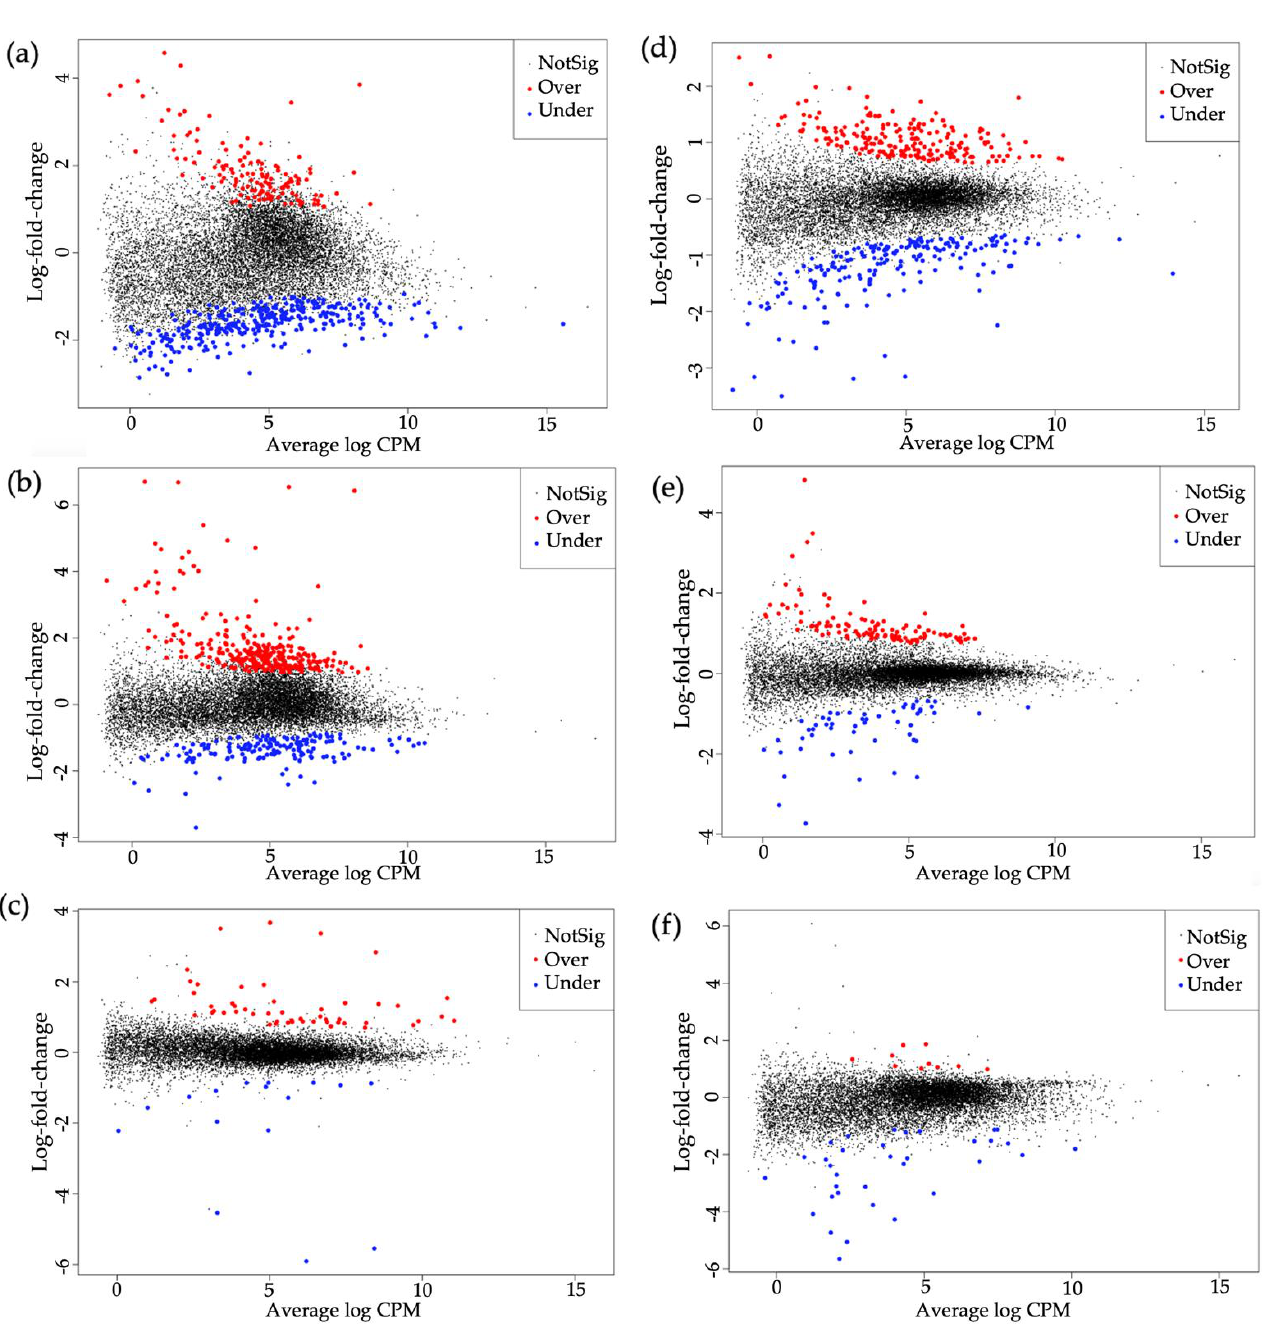
Figure 2. Mean difference plots of differentially expressed genes in B . tabaci Middle East-Asia Minor 1 (MEAM1) and Mediterranean (MED) adults provided with an acquisition access period of 72 h on virus-infected versus non-infected plants. Plots of log-intensity ratios (differences) versus log-inten- sity averages (means). CPM indicates counts per million reads. ( a ) B . tabaci MEAM1 adults with versus without TYLCV; ( b ) B . tabaci MEAM1 adults with versus without SiGMV; ( c ) B . tabaci MEAM1 adults with versus without CuLCrV; ( d ) B . tabaci MED adults with versus without TYLCV; ( e ) B . tabaci MED adults with versus without SiGMV; and ( f ) B . tabaci MED adults with versus with- out CuLCrV. Black, red, and blue dots are indicative of genes not significantly expressed, signifi- cantly overexpressed, or significantly underexpressed, respectively.